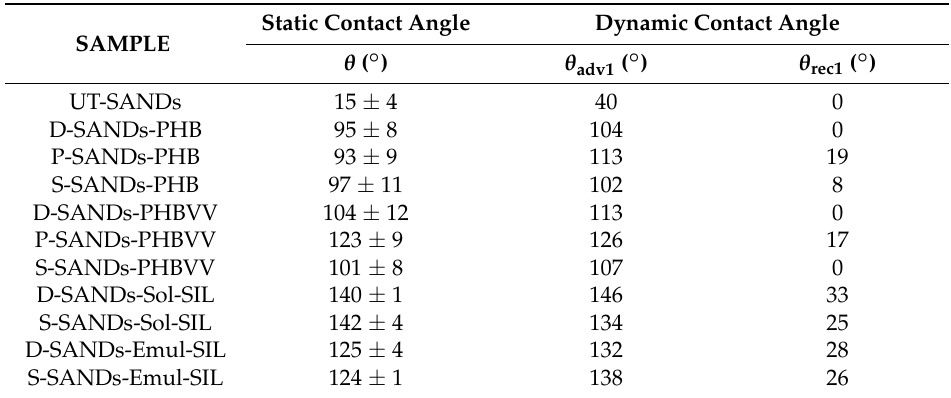
Table 5. Static contact angle ( θ ) and dynamic contact angles referred to the first immersion cycle ( θ adv1 , θ rec1 ) for untreated and treated sandstone.